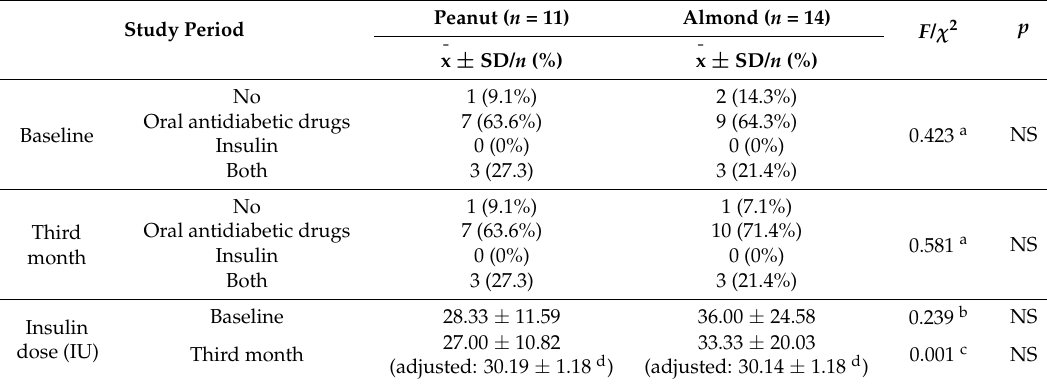
Table 7. Comparison of antidiabetic drugs between the two groups.